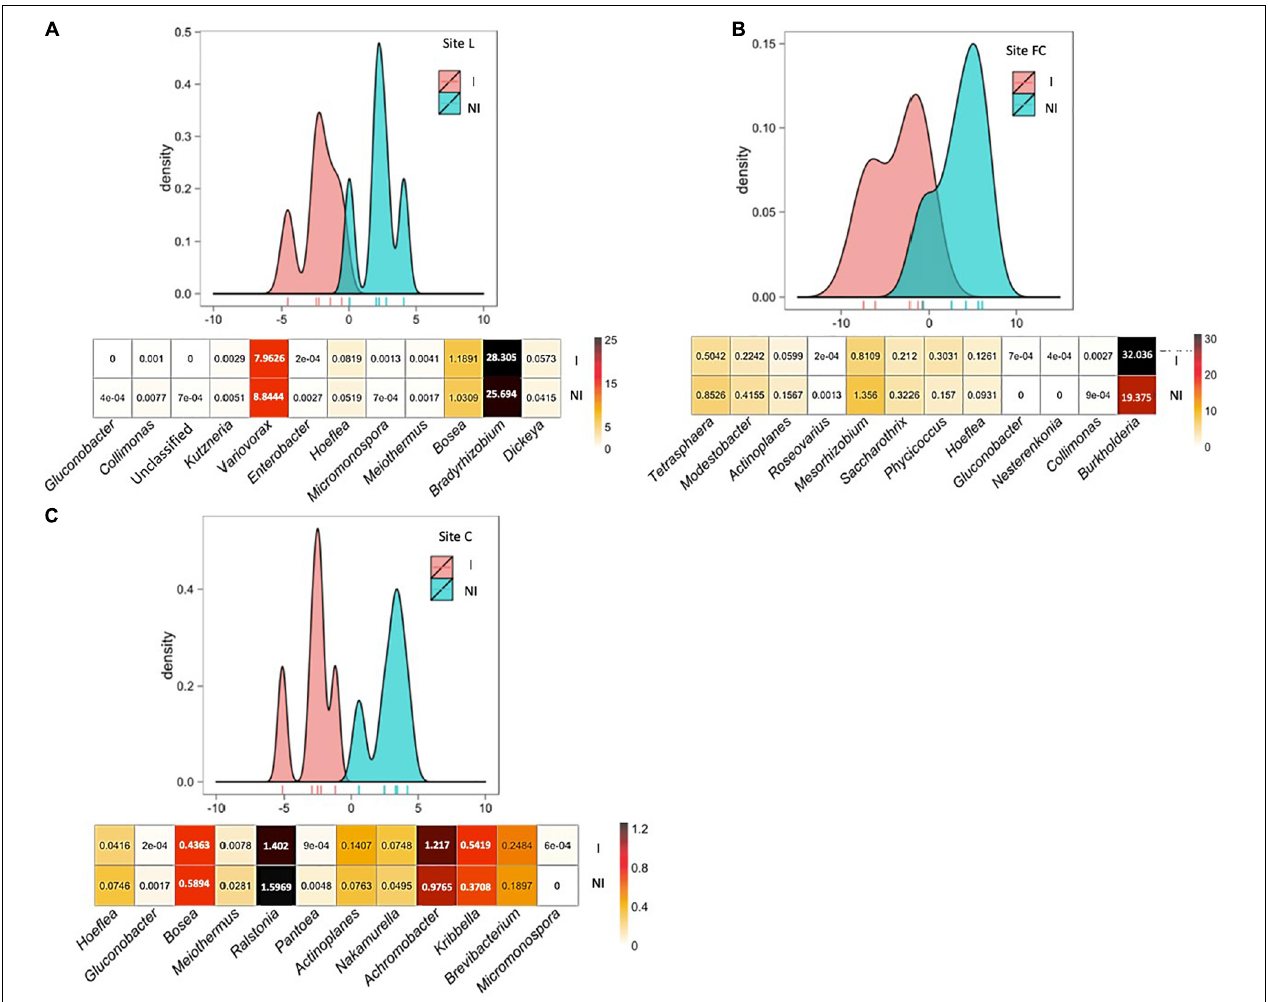
FIGURE 3 | Between-class analysis of the effect of seed inoculation with A. lipoferum CRT1 on the composition of the acdS functional group in the maize rhizosphere at the six-leaf stage at three field sites L (A) , FC (B) , and C (C) , in 2015. NI and I correspond, respectively, to non-inoculated and inoculated conditions. For each site, the BCA graph is completed (below) by the distribution of the bacterial OTUs according to their contribution to treatment differentiation; BCA is statistically supported by a Monte Carlo test at sites L ( p = 0.012), FC ( p = 0.005), and C ( p = 0.013), and the heatmap below indicates the average relative proportions for the 12 bacterial genera most impacted by inoculation in maize rhizosphere. Six bacterial genera most commonly associated with inoculation are indicated at the left, as well as six bacterial genera most often associated with the non-inoculated control (right). Differences between inoculated and non-inoculated treatments were not statistically significant (Wilcoxon test, p < 0.05). Heatmap unit is a percentage of the average relative proportion of